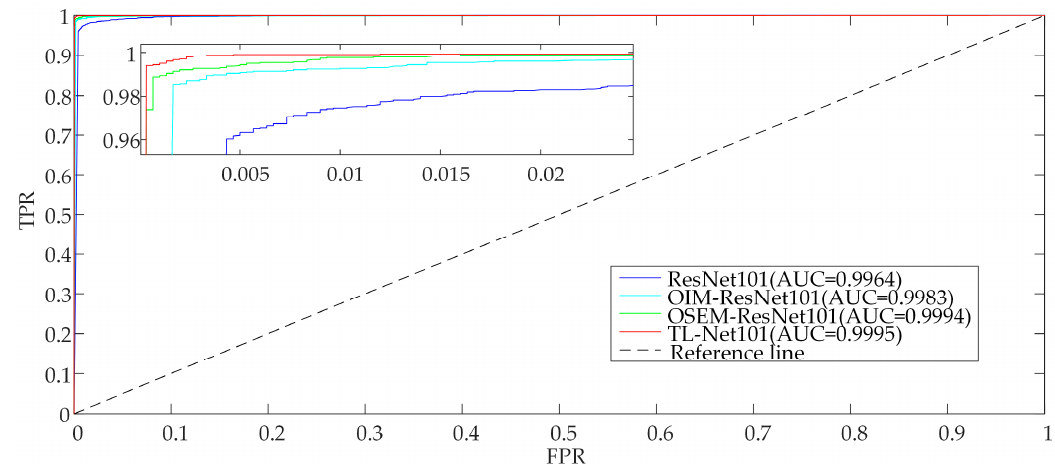
Energies 2020 , 13 , x FOR PEER REVIEW Figure 9. The ROC curves of ResNet50, OIM-ResNet50, OSEM-ResNet50, and TL-Net50.